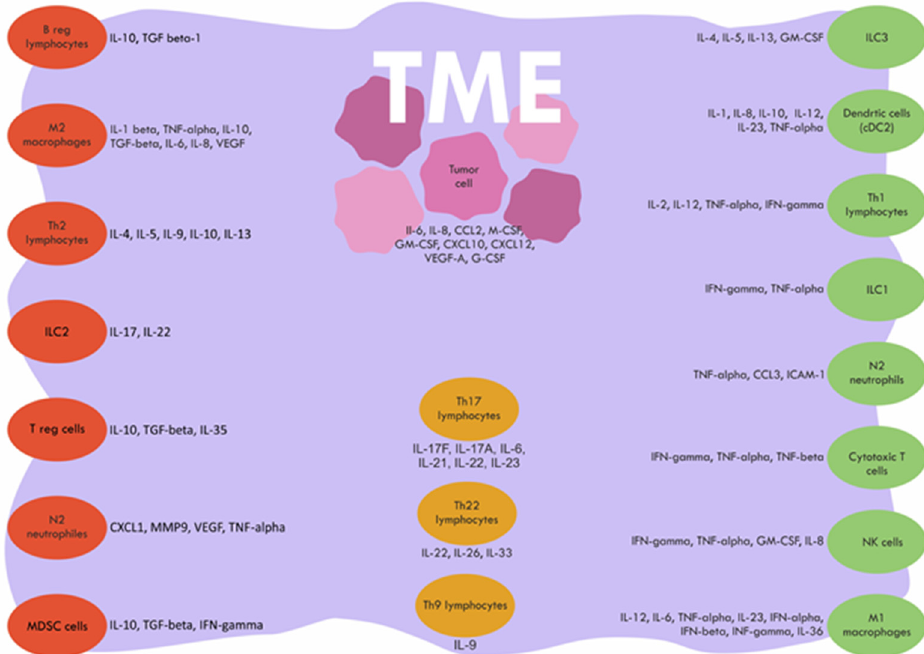
Figure 1. Several cell types in tumor histology were found to be associated with poor patient outcomes. These cells include M2 tumor-associated macrophages, N2 neutrophils, MDSCs (myeloid-derived suppressor cells), regulatory T cells (Treg cells), subsets of T helper lymphocytes: Th2, Th9, and Th17 cells, cancer-associated fibroblasts (CAF), and regulatory B cells (Breg) cells playing mostly tumor-promoting functions. Other cells in TME showed antitumor activity related to a favorable prognosis. This group of cells includes tumor associated macrophages of M1 phenotype, N1 neutrophils, Th1 cells, cytotoxic T cells, innate lymphoid cells (ILC) with natural killer (NK cells) cells. Some cells subtypes, like Th9, Th17, Th22 may play a dual, pro-tumor, or antitumor role depending on the TME polarization. Mutual crosstalk among TME cells may shift the balance into immune suppressive or antitumor immunity, this way influencing patients’ prognosis. Still, it is not fully known, how the tumor structure translates into cancer-related inflammation and systemic cytokine levels. To address this question, we analyzed cytokines levels from clinical trials in different CRC stages. Results are shown in Tables 1 and 2 and discussed in the following sections. Table 1. Systemic cytokine levels in CRC patients vs. controls. Groups containing more than 1 stage were assessed as a whole.